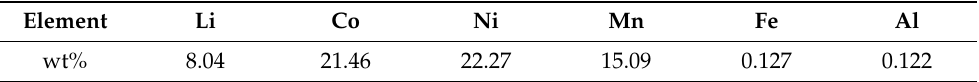
Table 1. The main metal contents in cathode materials of spent lithium batteries. Element Li Co Ni Mn